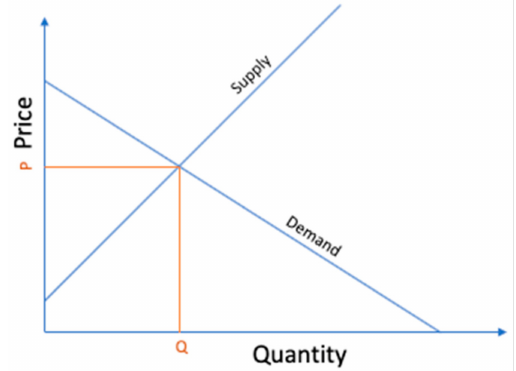
Figure 2. E ffi cient market